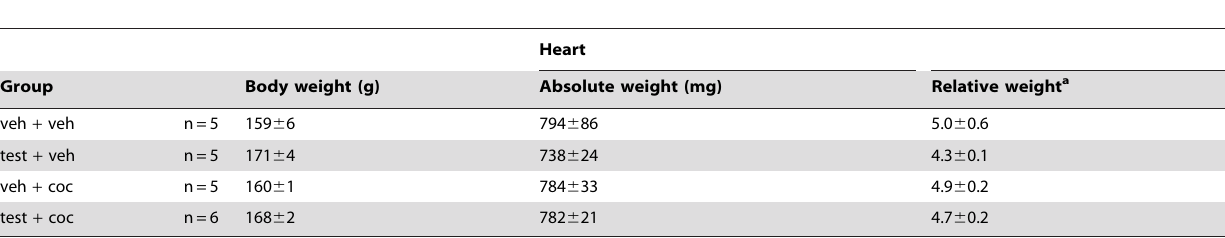
Table 1. Body and heart (absolute and relative) weight in adolescent animals subjected to treatment with testosterone and cocaine alone and in combination for 10 consecutive days.